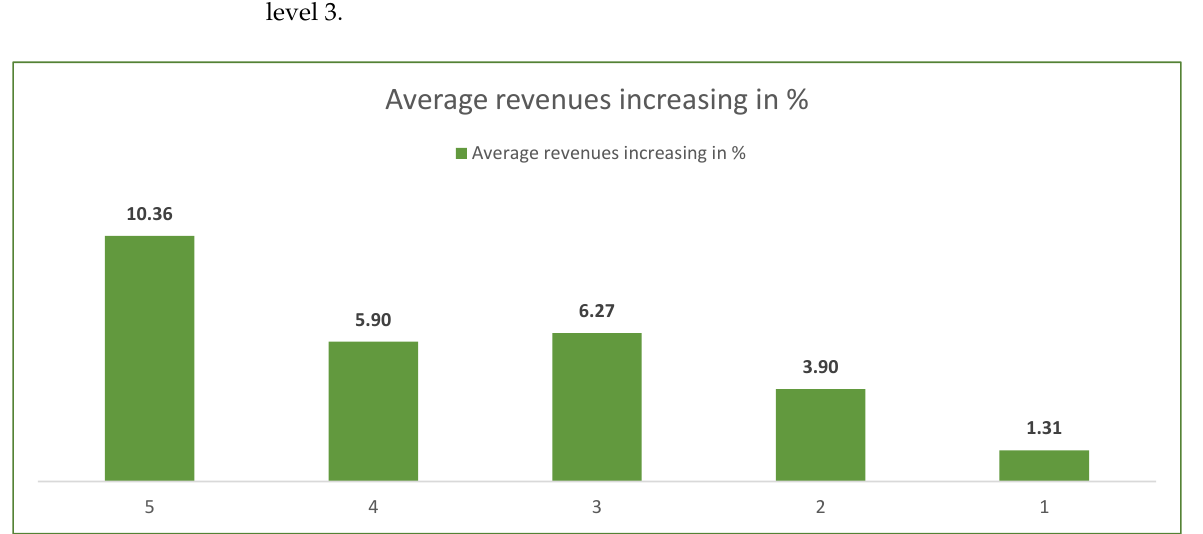
Figure 8. Percentage changes in revenues according to the ERP exploitation level.